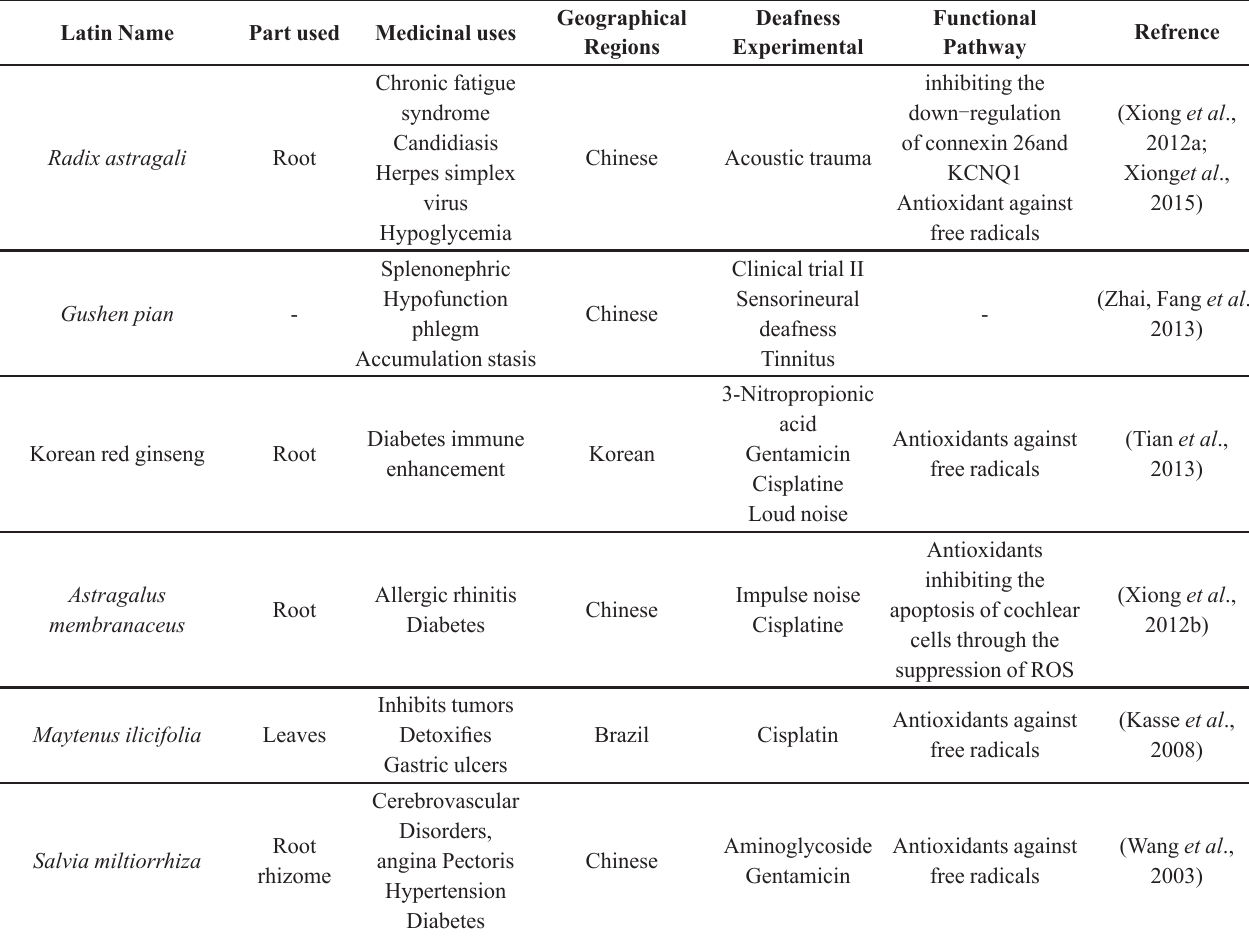
TABLE I - The list of medicinal plants used to treat ototoxicity induced by gentamicin, cisplatine and noise in the